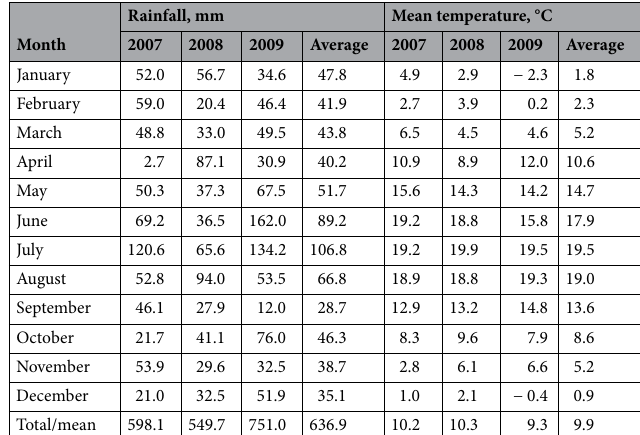
Table 1. Monthly precipitation and average daily air temperature at the experiment site from 2007 to